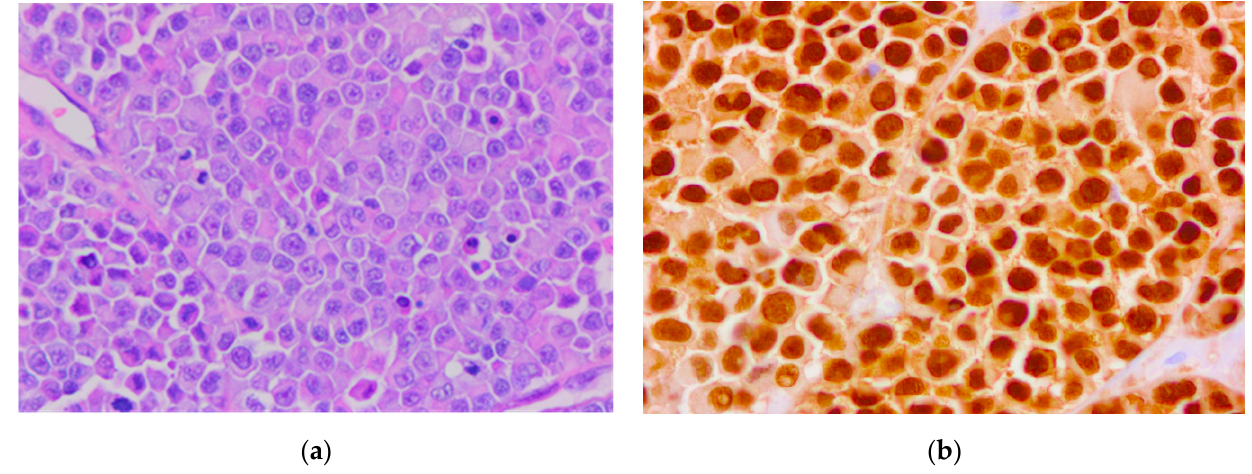
Figure 15. In-transit metastasis. ( a ) Hematoxylin-eosin staining. ( b ) Immunostaining with SOX10. Both images were taken at 40× magnification. (Collection of Pathology Department SCJ Mure ș ).